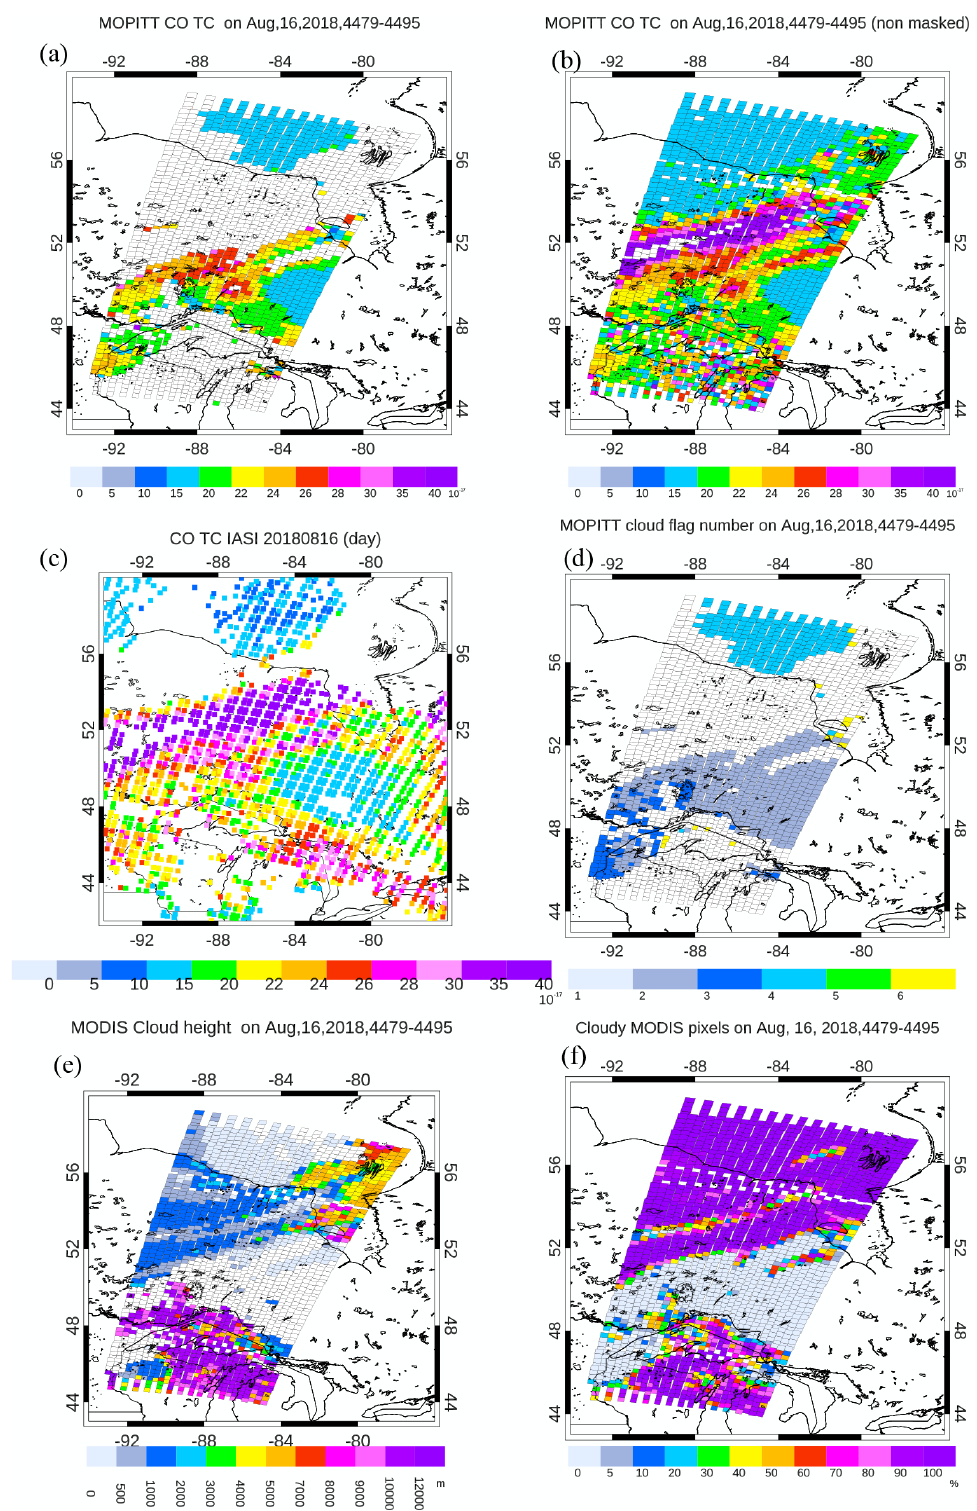
Figure 6. (a) Standard (cloud-masked), (b) non-standard (non-cloud-masked) CO TC, (c) IASI CO TC, (d) MOPITT cloud flag number, (e) MODIS cloud height, and (f) cloud mask on 16 August 2018. The faint black squares represent MOPITT pixels (22km × 22km) for all L1